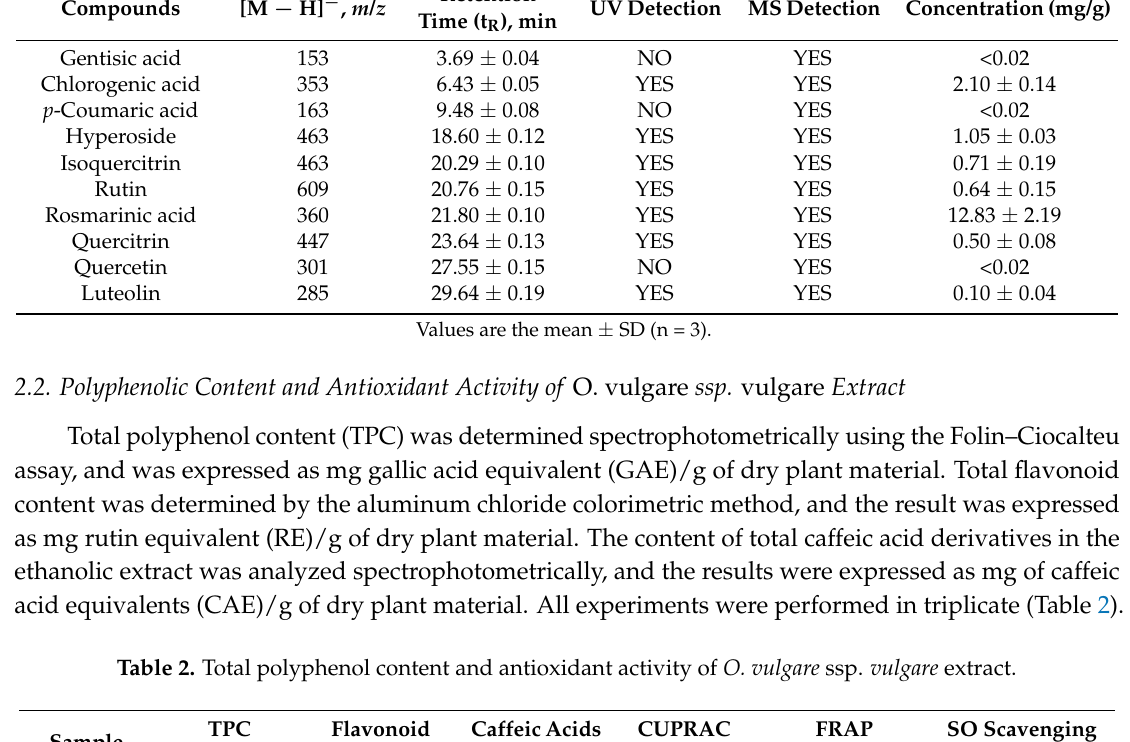
Table 1. Phenolic compounds determined by the HPLC method in O. vulgare ssp. vulgare extract. Retention Compounds [M − H] − , m / z UV Detection Time (t R ), min